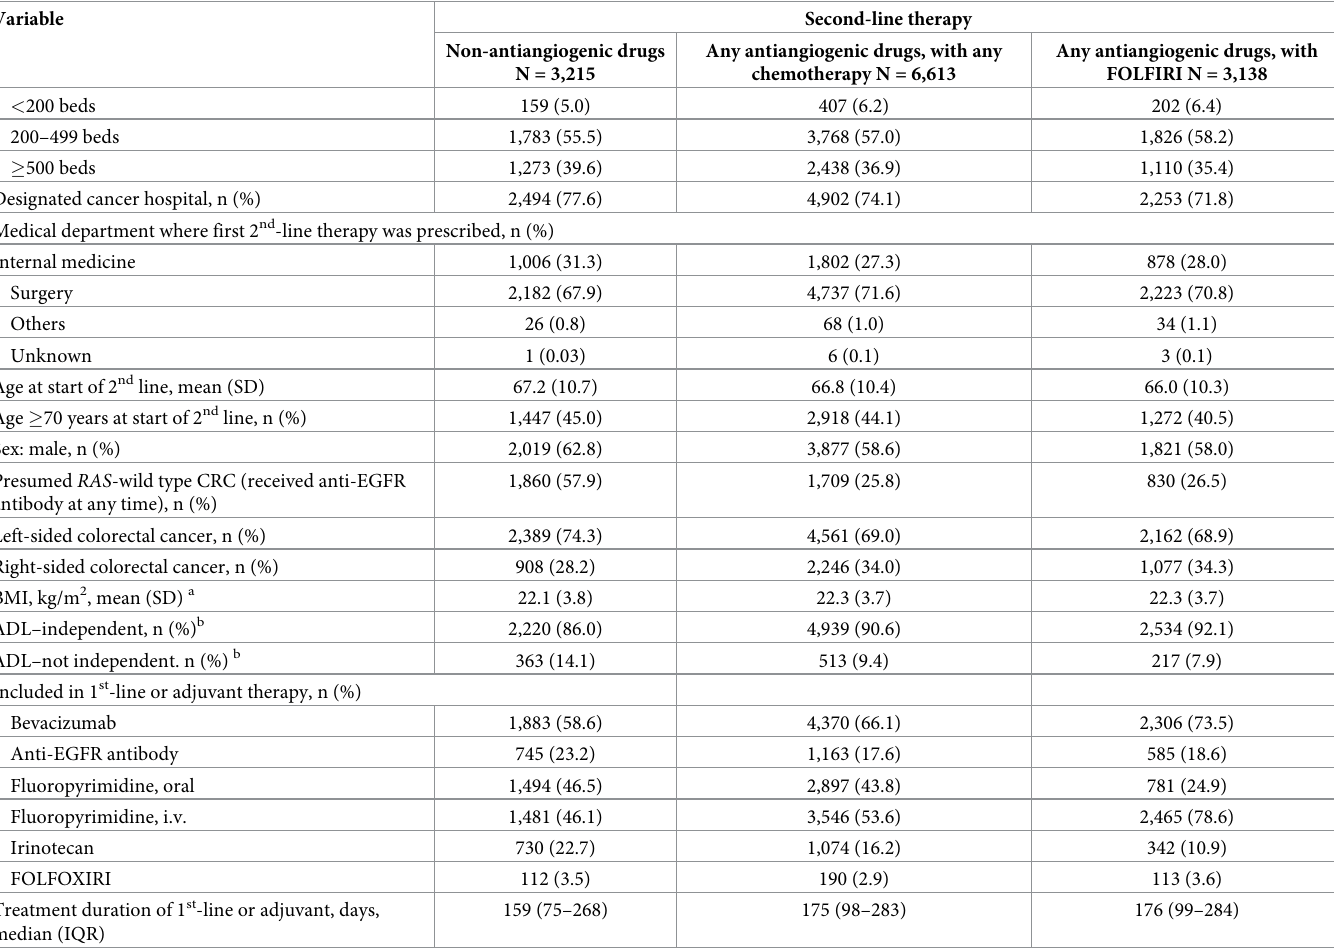
Table 2. Baseline demographics and clinical characteristics of patients with CRC in the combined first-line and early recurrence populations, categorised by use of antiangiogenic drugs as second-line